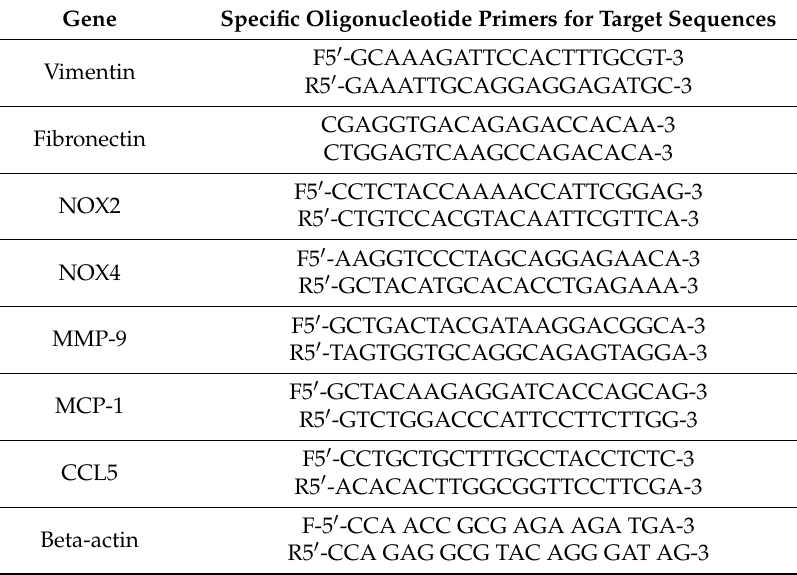
Table 2. The primer